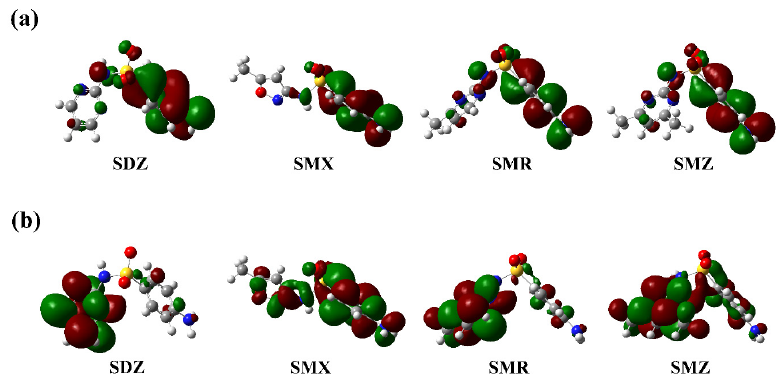
Figure 5. The HOMO ( a ) and LUMO ( b ) electron density contour of SDZ, SMX, SMR, and SMZ. The substituted heterocyclic rings and aniline are on the left and right sides of the SA molecules, respectively. According to the front molecular orbital (FMO) theory, the energy gap ( ∆ E ) between